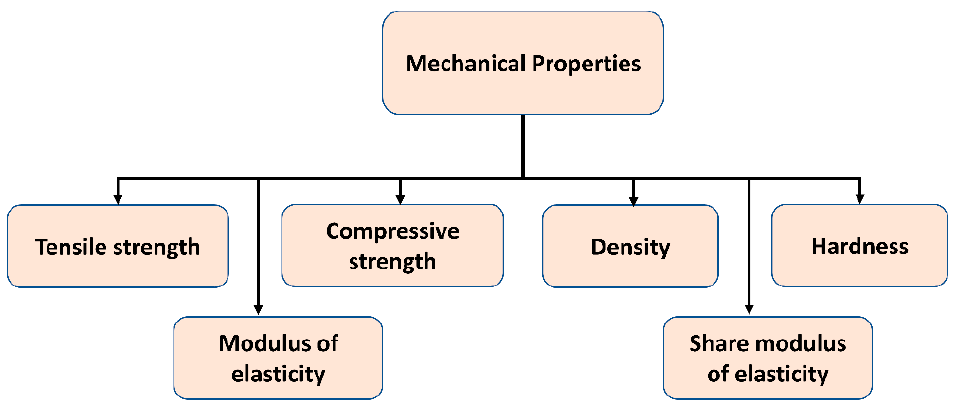
Figure 3. Mechanical properties of bone.